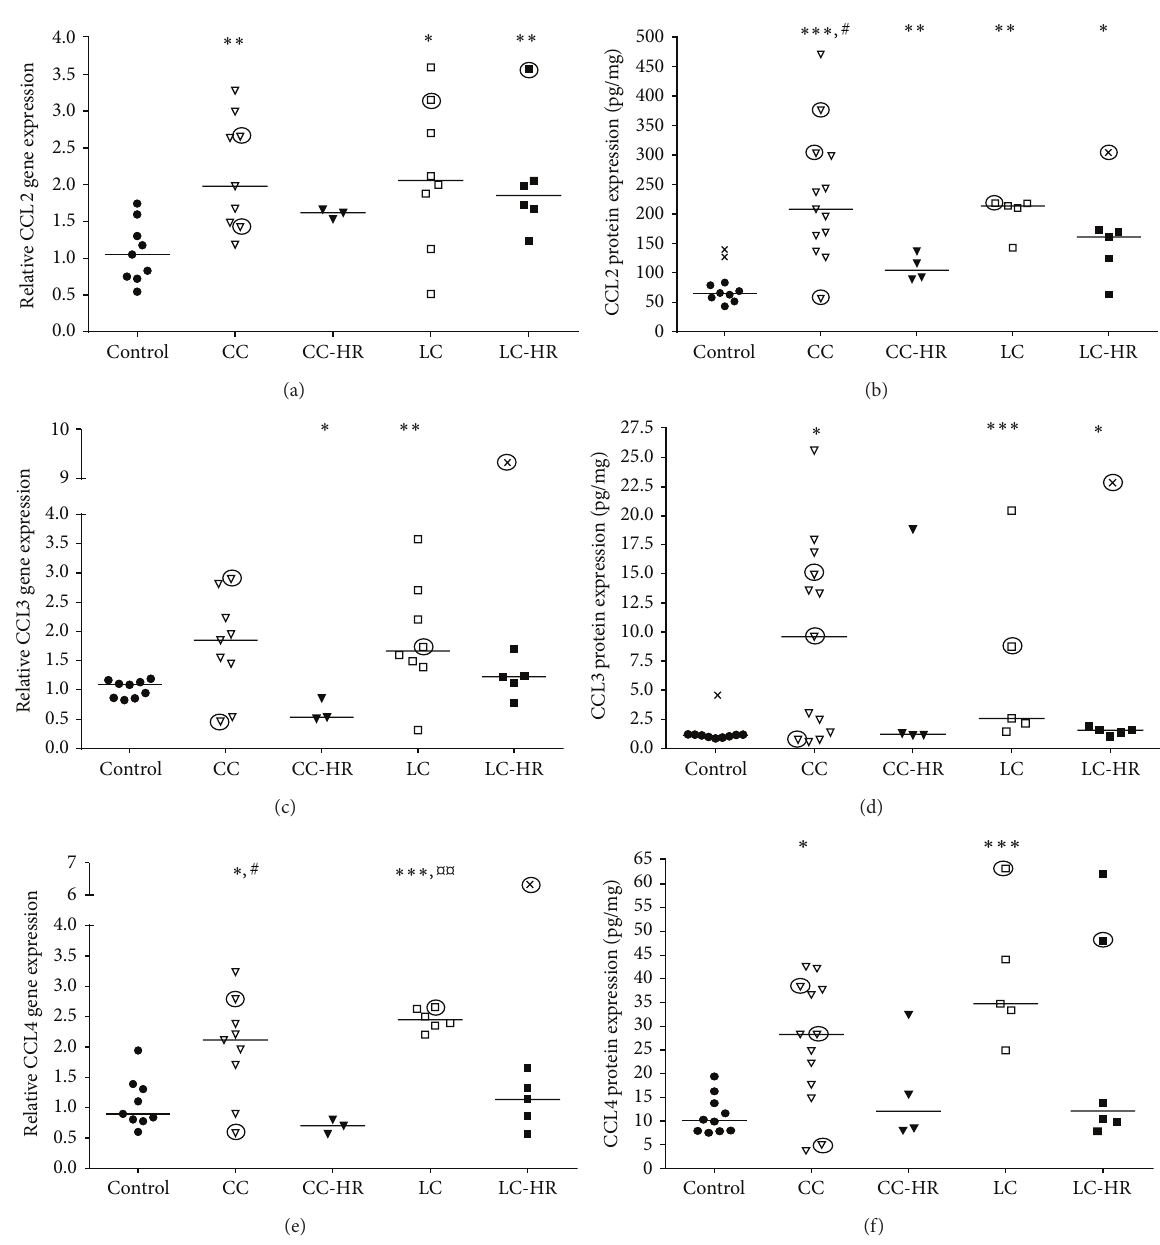
Figure 5: Relative gene and protein expressions of chemokines mediating recruitment of eosinophils, neutrophils, macrophages, Treg, Th1, and/or Th2 cells. Each symbol represents one patient and the medians are depicted as a line. Statistical outliers are marked as crosses (X) and budesonide treated patients are encircled. ∗ 𝑃 < 0.05 , ∗∗ 𝑃 < 0.01 , and ∗∗∗ 𝑃 ≤ 0.001 versus controls, # 𝑃 < 0.05 versus CC-HR, and ¤ 𝑃 < 0.05 , ¤¤ 𝑃 < 0.01 versus